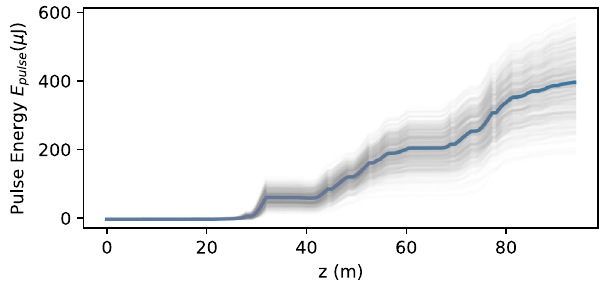
FIG. 9. Multiple-shot FEL pulse energy profile along the undulator beam line. The blue line shows the evolution of the ¯ P ð z Þ in the undulator beam line. averaged XFEL pulse energy pulse